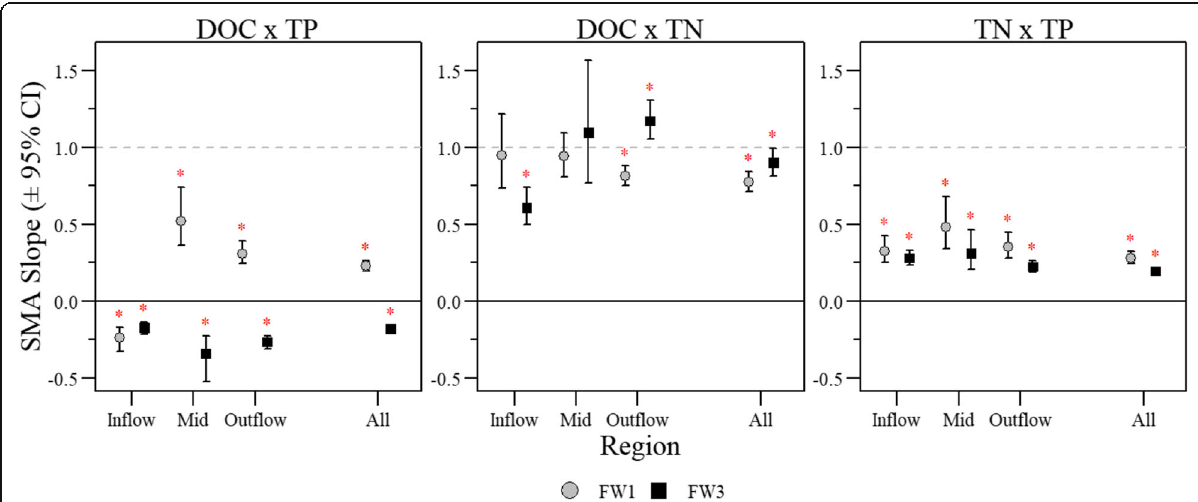
Fig. 8 Surface water inflow, mid, outflow, and overall standardized major axis slope values with ± 95% confidence interval for dissolved organic carbon (DOC), total phosphorus (TP), and total nitrogen (TN) comparisons. Slopes significantly different from one are identified with red asterisks above the upper 95% confidence interval bar